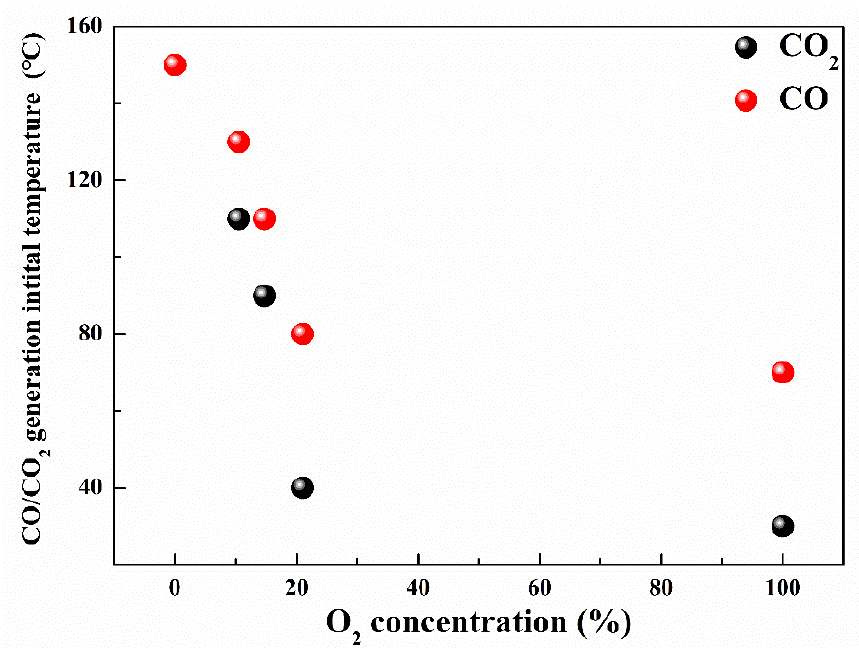
Figure 3. Initial temperature of CO and CO 2 generation at different oxygen concentrations.